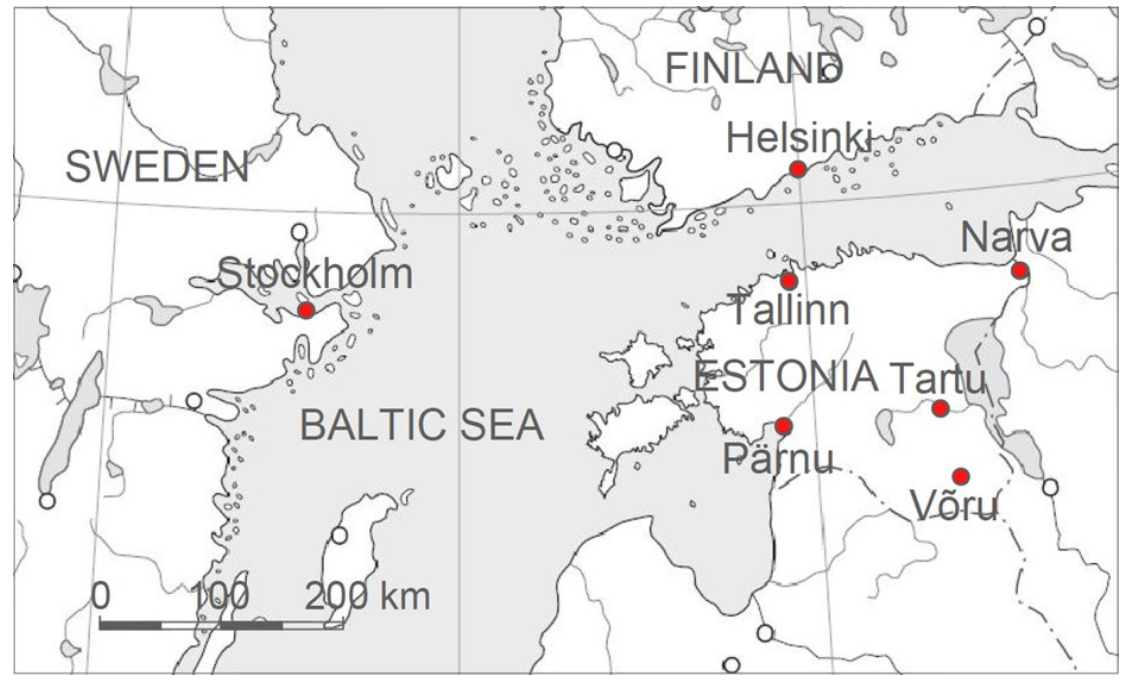
Figure 1. Map of the central Baltic area.